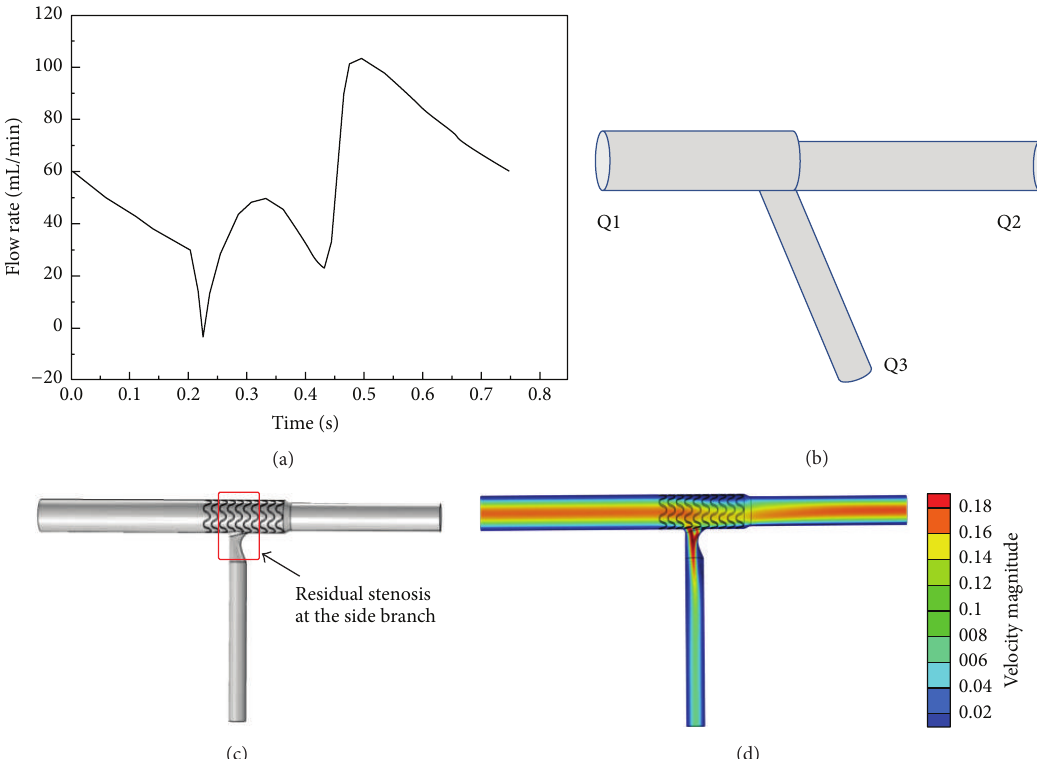
Figure 2: (a) Imposed inflow boundary conditions. (b) Outflow boundary conditions. (c) Idealized left main bifurcation model of crossover stenting followed by final kissing balloon angioplasty under right bifurcation angle condition. A residual diameter stenosis of 30% is considered at the proximal LCX. (d) The numeric solution of flow velocity